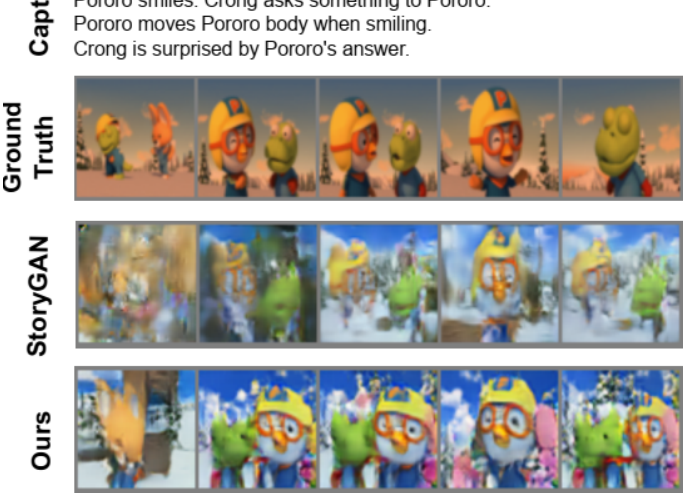
Figure 10. Example of Pororo-SV dataset, reproduced from [237].